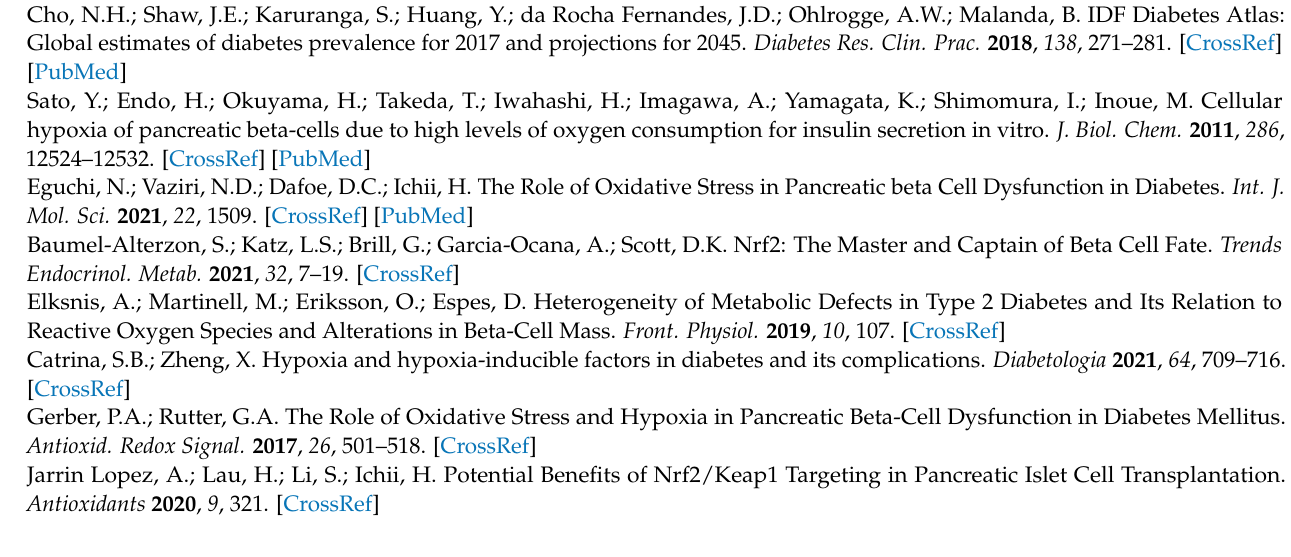
Supplementary Table S2: Western blot antibody